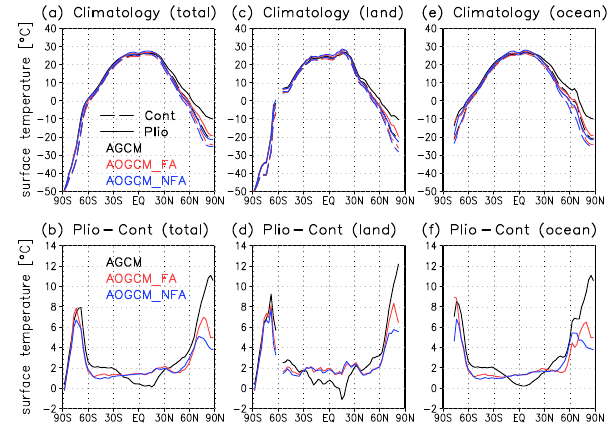
Fig. 4. (a, c, e) Zonal-mean SAT (°C) for the Control (dashed lines) and Pliocene (solid lines) and (b, d, f) their differences.